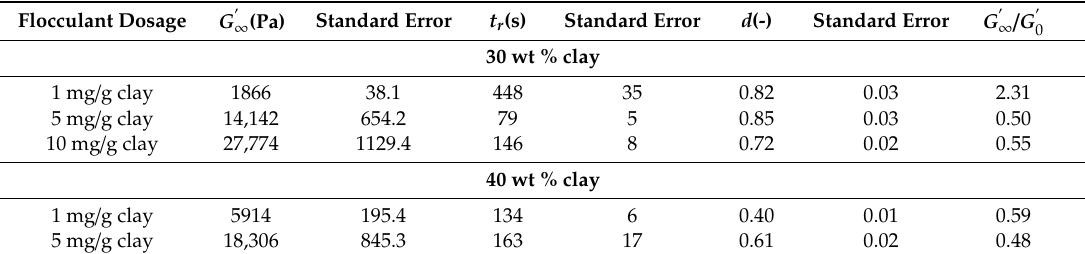
Figure 14. Normalized storage modulus as a function of time, after the pre-shearing step, for di ff erent clay suspensions having ( a ) 30 wt % and ( b ) 40 wt % clay with di ff erent amounts of cationic flocculant, solid lines represent the empirical model fitting. Table 4. The values of the fitting parameters of Equation (4) for cationic polyelectrolyte based clay suspensions.